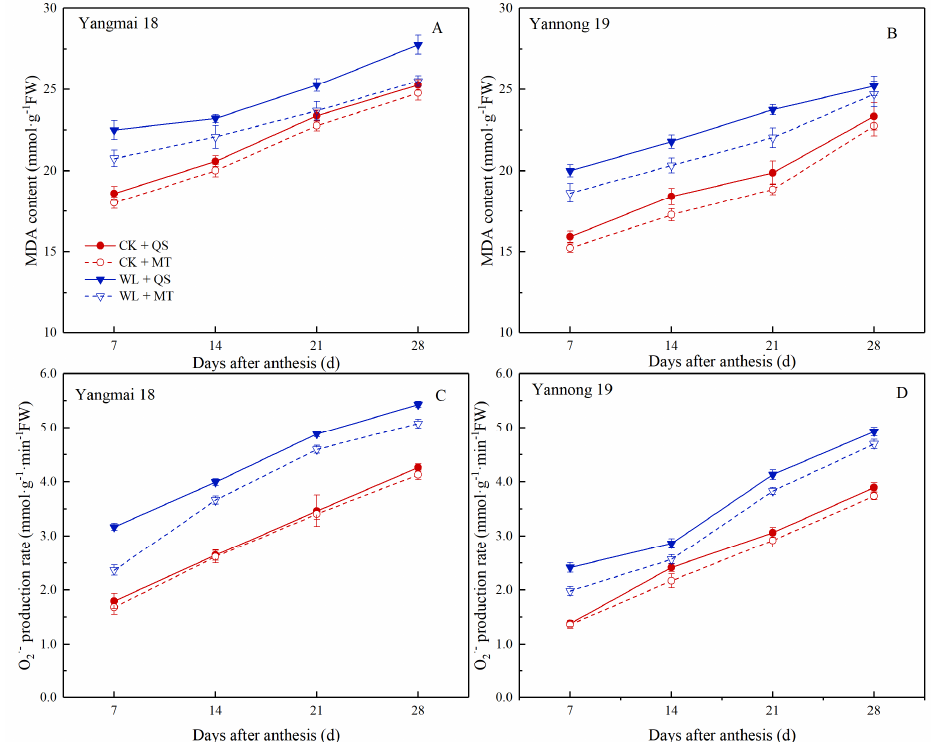
Figure 5. Post-flowering changes in root malondialdehyde (MDA) content and O 2– production rate of Yangmai 18 ( A , C ) and Yannong 19 ( B , D ) under different treatments, i.e., CK + QS: leaf spraying with distilled water under non-waterlogged conditions; CK + MT: leaf spraying with 100 μmol·L −1 of melatonin under non-waterlogged conditions; WL + QS: leaf spraying with distilled water under waterlogged conditions; WL + MT: leaf spraying with 100 μmol·L −1 of melatonin under waterlogged conditions.